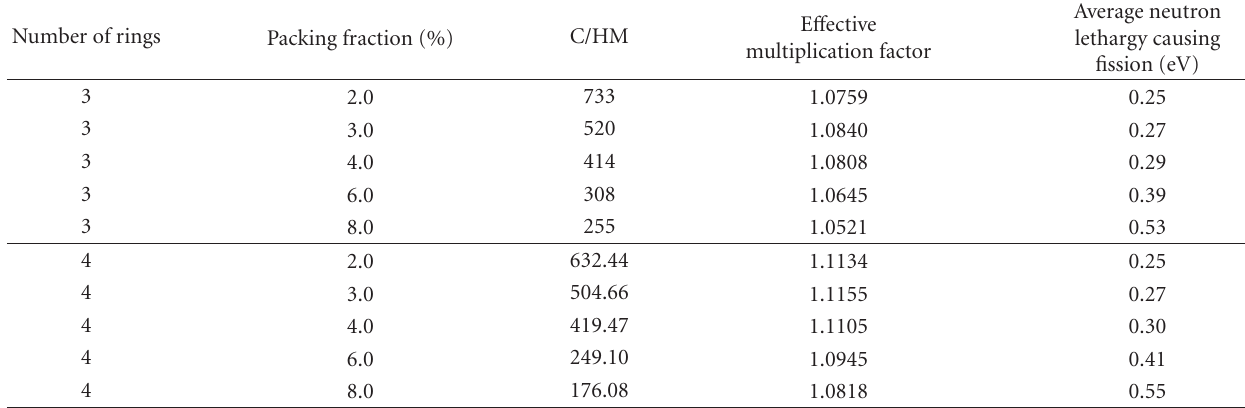
Table 4: Reactor physics parameters for three and four ring TRU-VHTR configurations.